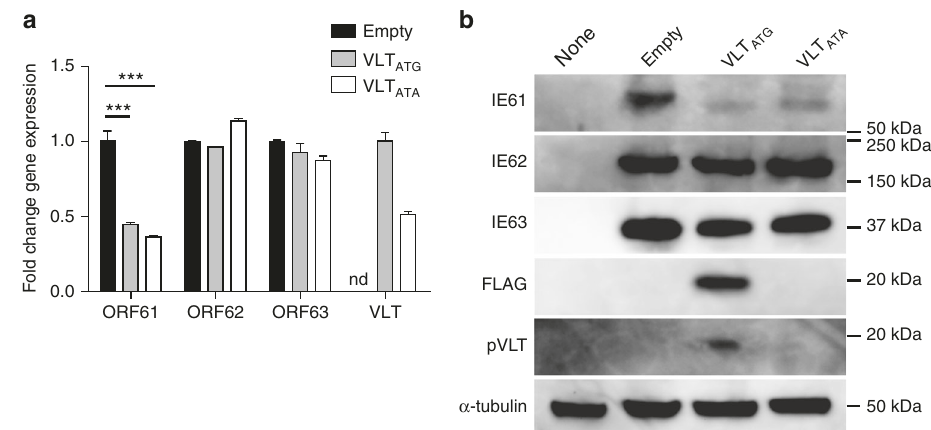
Fig. 6 Selective repression of VZV ORF61 gene expression by VLT in co-transfected cells. ARPE-19 cells were transfected with plasmids encoding FLAG-tagged VLT (VLT ATG ), mutated VLT in which the ATG start codon was replaced by ATA sequence (VLT ATA ) or empty control plasmid (empty) in combination with plasmids encoding ORF61, ORF62 and ORF63. a Analysis of VZV ORF61, ORF62 and ORF63 and human β -actin transcript by RT- qPCR. Data represent mean (±SEM) fold-change in gene expression using the empty vector to calibrate ORF61, ORF62 and ORF63 or using VLT ATA to calibrate VLT ATG. Data are from two independent experiments performed in duplicate. nd not detected. *** p < 0.001; one-way ANOVA with Bonferroni ’ s correction for multiple comparisons. b Western blot analysis using antibodies directed to proteins encoded by VZV ORF61 (IE61), ORF62 (IE62), ORF63 (IE63), VLT (pVLT) and FLAG-tagged pVLT and α -tubulin. None, untransfected ARPE-19 cells. Images are representative of